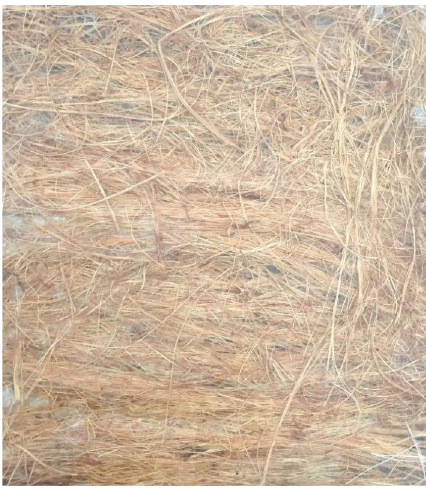
Figure 3: Fabricated composite